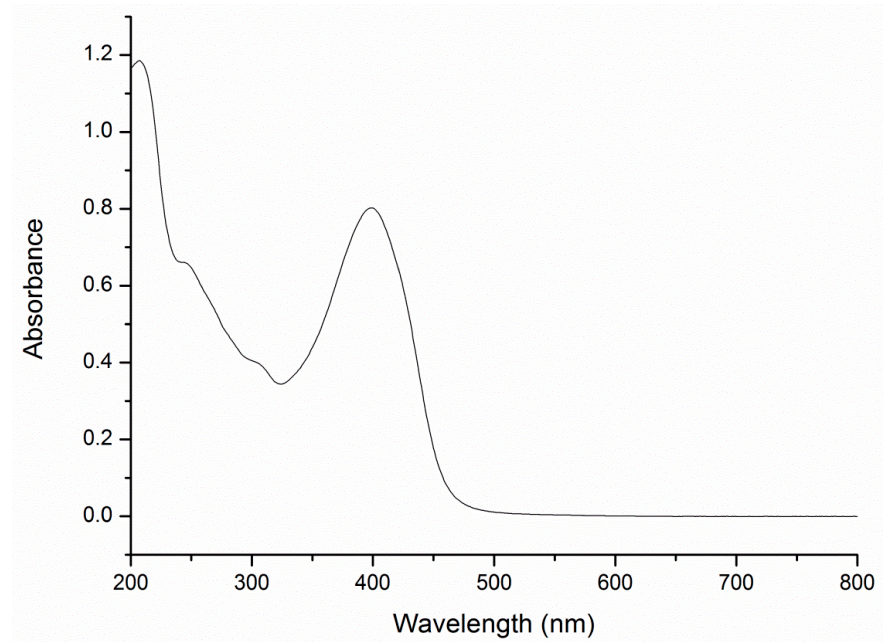
Figure A2. UV-Vis spectrum of ( 1-L4 ) in MeCN: λ max1 = 399 nm, ε = 2.47 × 10 4 M − 1 cm − 1 , λ max1 = 305 nm, ε = 1.23 × 10 4 M − 1 cm − 1 , λ max1 = 246 nm, ε = 2.03 × 10 4 M − 1 cm − 1,